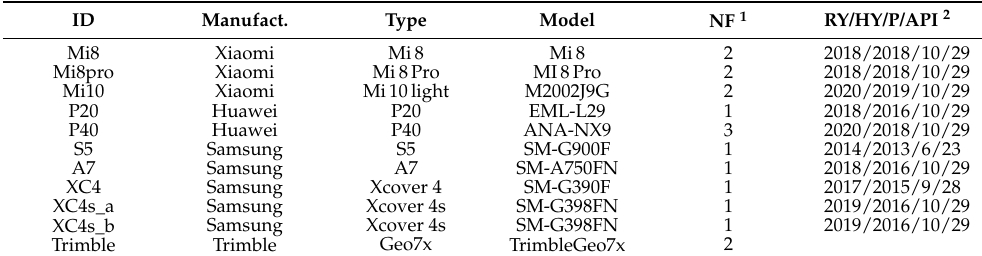
Table 1. Overview of the smartphones and GNSS receivers used in the empirical experiments ( 1 Num-